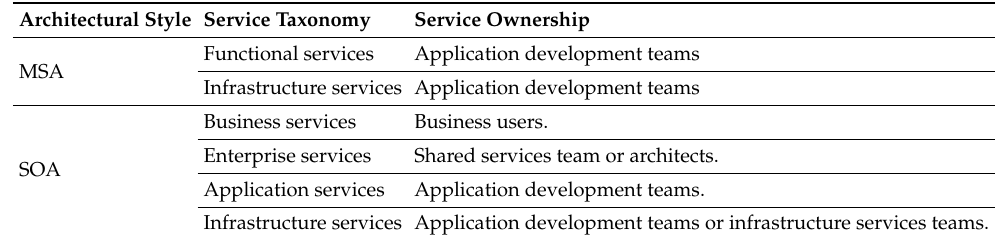
Table 1. Comparison of service characteristics in MSA and